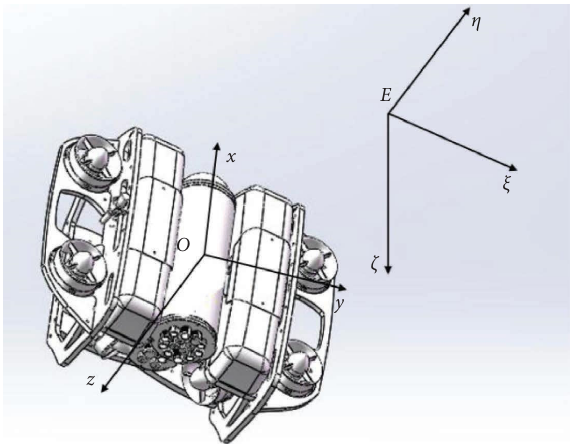
Figure 1: Relative coordinate system of a underwater